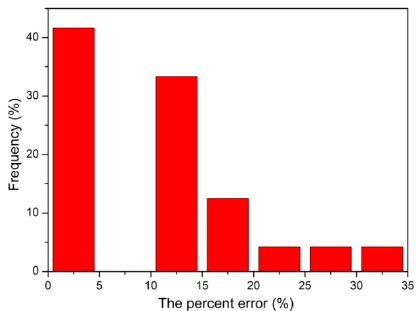
Figure 5. The frequency distribution of percent errors on ET estimates.